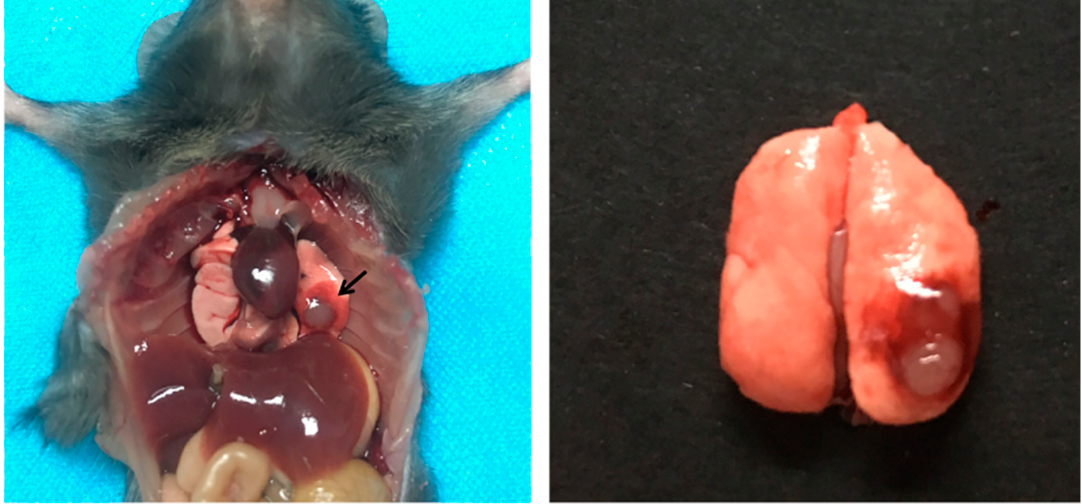
Figure 10. Orthotopic lung cancer model in C57BL/6 mice.